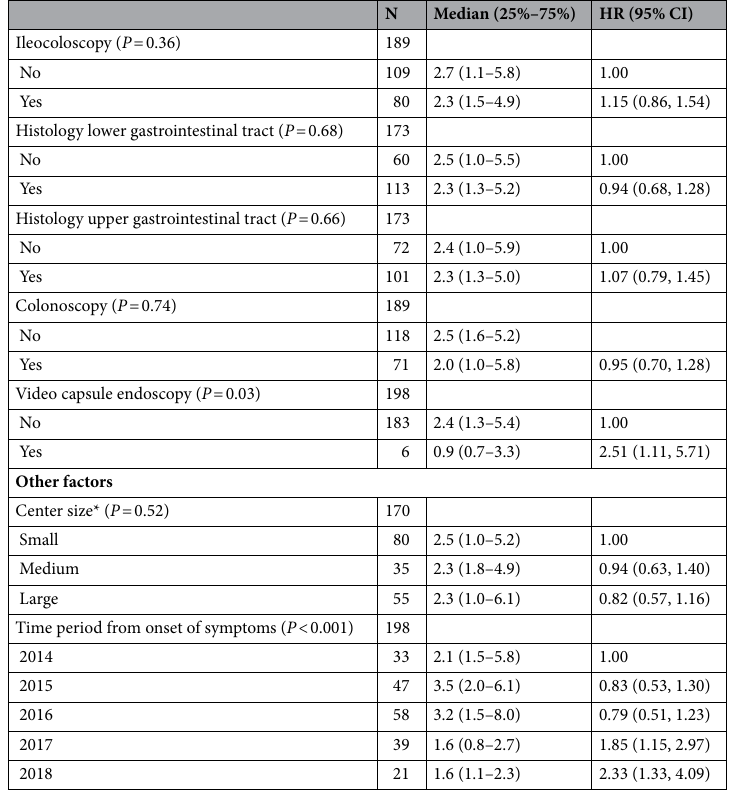
Table 2. Univariate analysis of factors influencing diagnostic delay (in months) in children and adolescents with Ulcerative colitis (Hazard ratio < 1: longer, hazard ratio > 1: shorter). *small = < 25 PIBD patients per year; medium = 25–100 PIBD patients per year; large = > 100 PIBD patients per